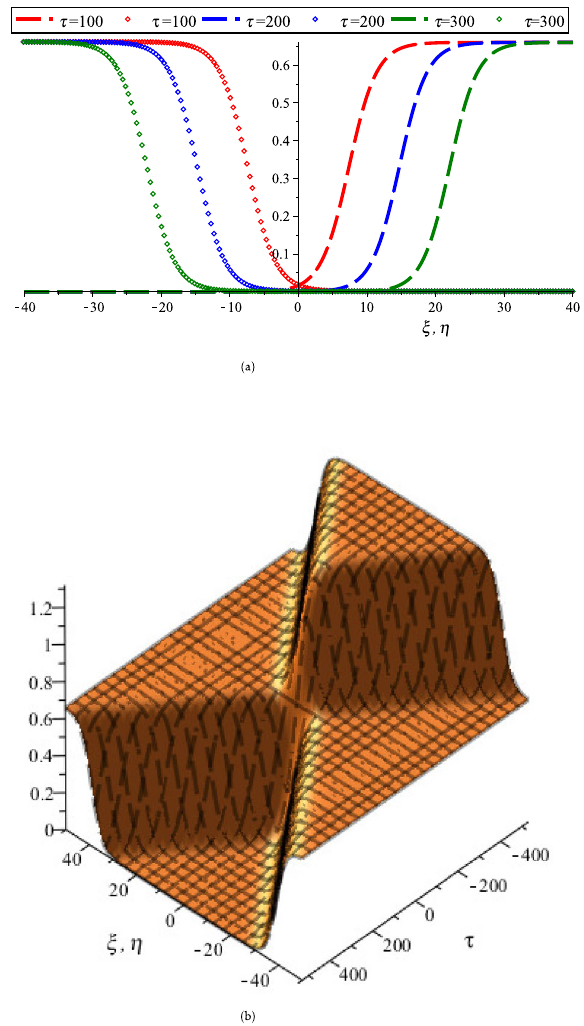
( 1 ) , τ) [Dashed dotted l (ξ